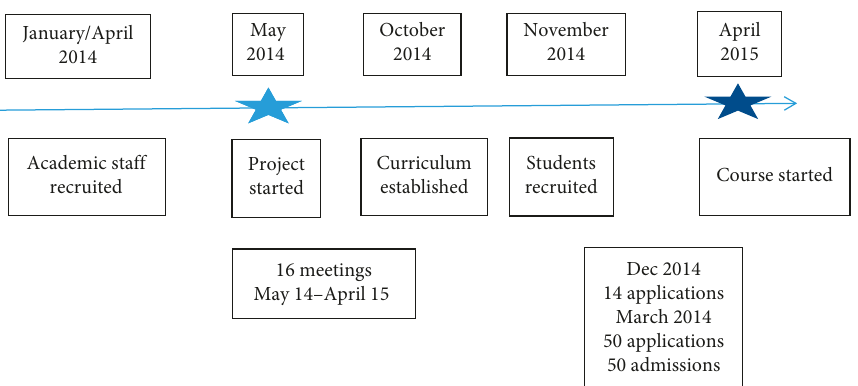
Figure 1: Structure and timetable of the development